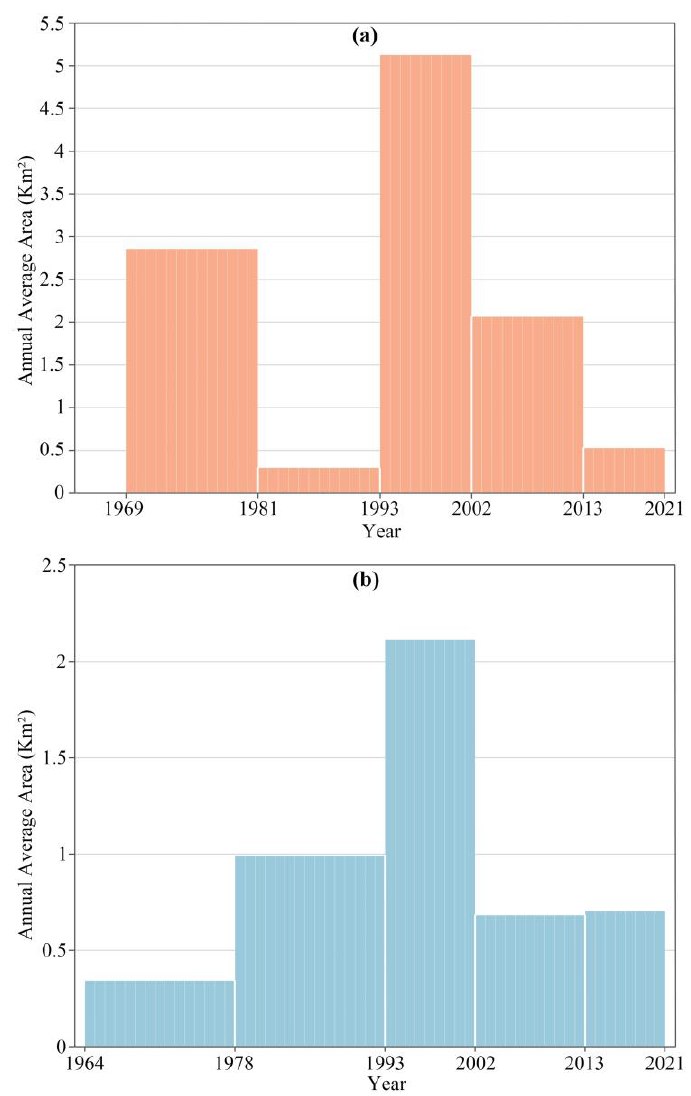
Figure 8. Reclamation area ( a ) and natural expansion area ( b ) of tidal wetlands in Yueqing Bay.